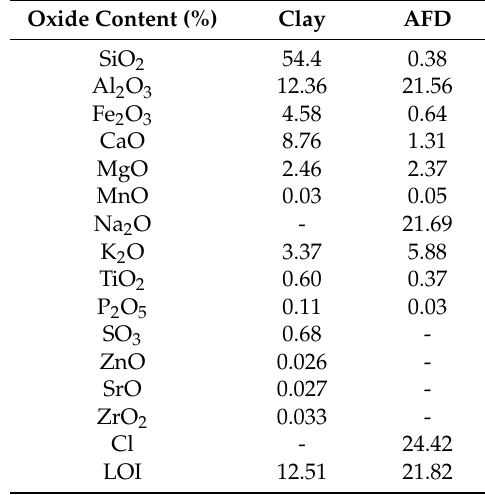
Table 2. Chemical composition of clay and aluminum filter dust.